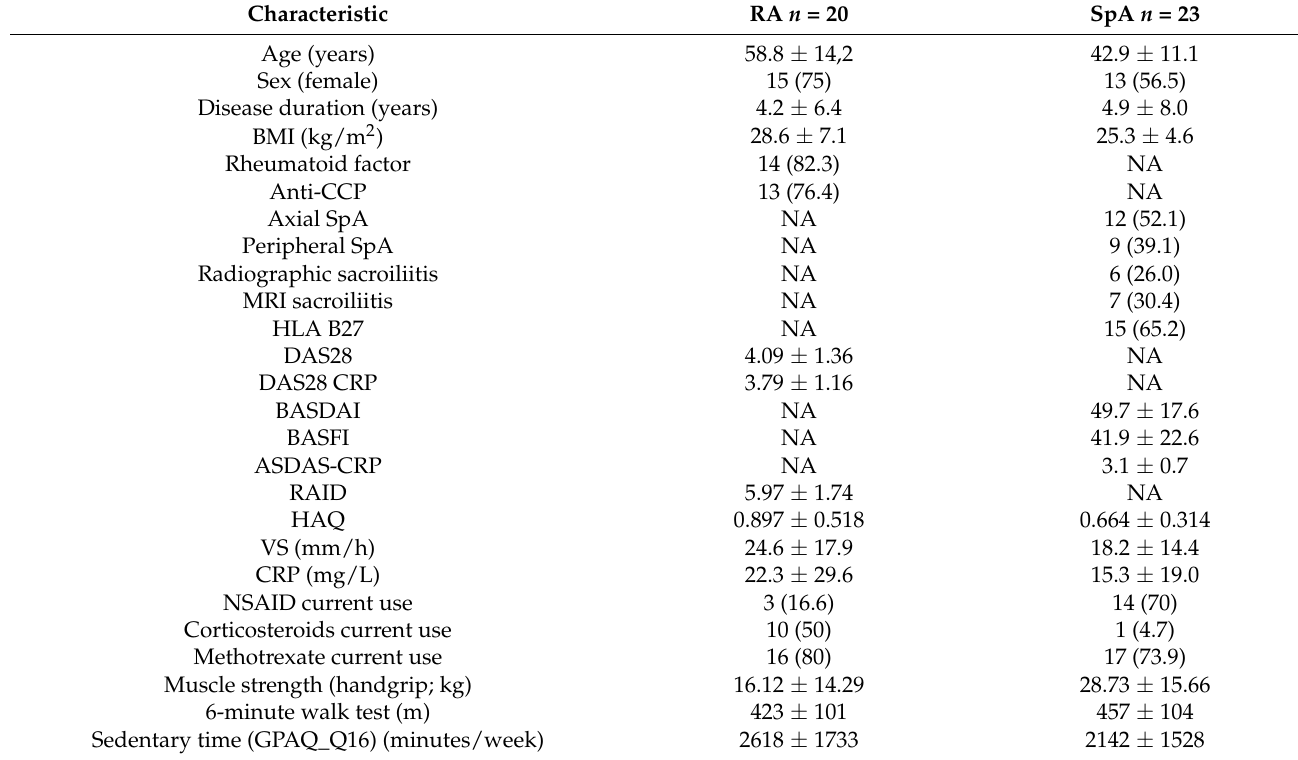
Table 1. Characteristics of patients with rheumatoid arthritis (RA) or spondyloarthritis (SpA).